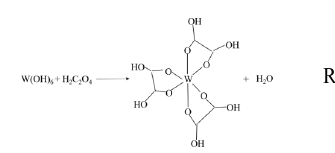
Further increase in the additives did not lead to apparent changes in shape and size of the particles, but it seems some particles possess regular form, as illustrated in Figure